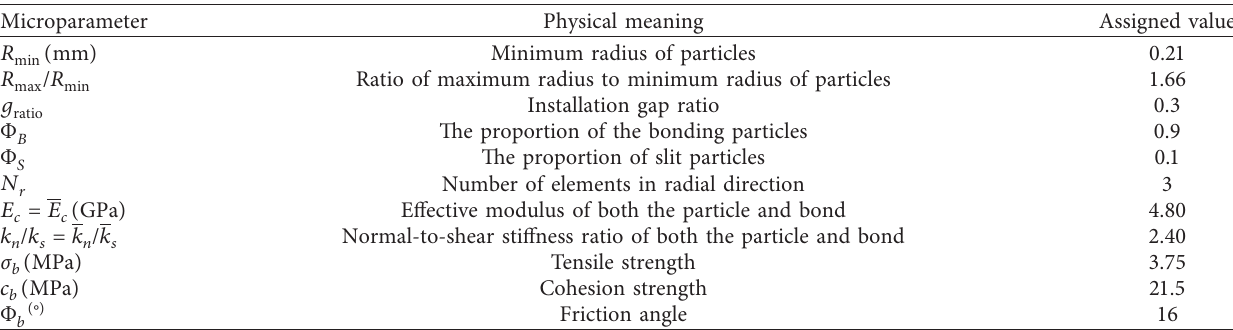
Figure 12: Model established by FJM corresponding to the experiment. Table 6: Microparameters of the FJM.